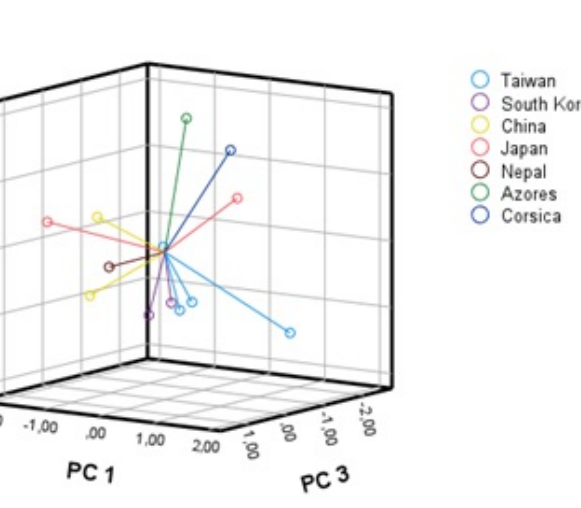
Figure 2. 3D loading plot of principal components PC1, PC2 and PC3 for Cryptomeria japonica essential oil, based on the major constituents ( A ) and 3D score plot of C. japonica essential oil setting by its geographical origin ( B ). Table 2. Principal components data, based on 14 major compounds of Cryptomeria japonica essential oils.